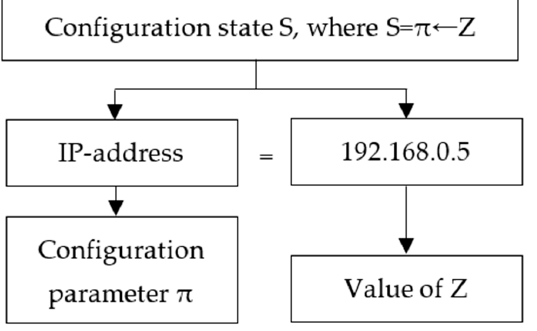
Figure 7. Host Π configuration Figure 7. Host П configuration example.